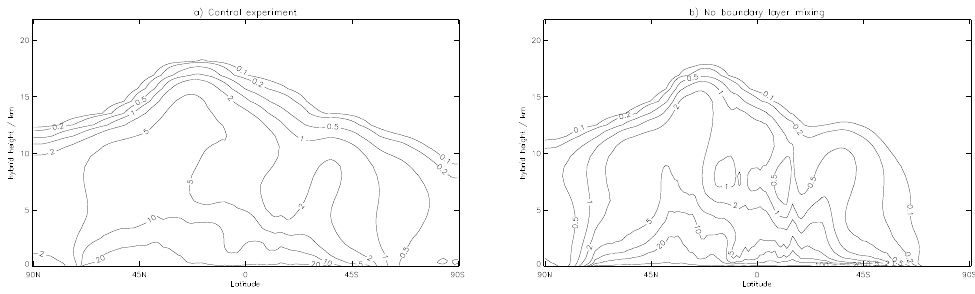
Fig. 2. Multi-annual zonal mean radon concentrations in units of 10 − 21 mol mol − 1 for (a) the control experiment and (b) an experiment with no boundary layer mixing for the June-July-August (JJA) time period.